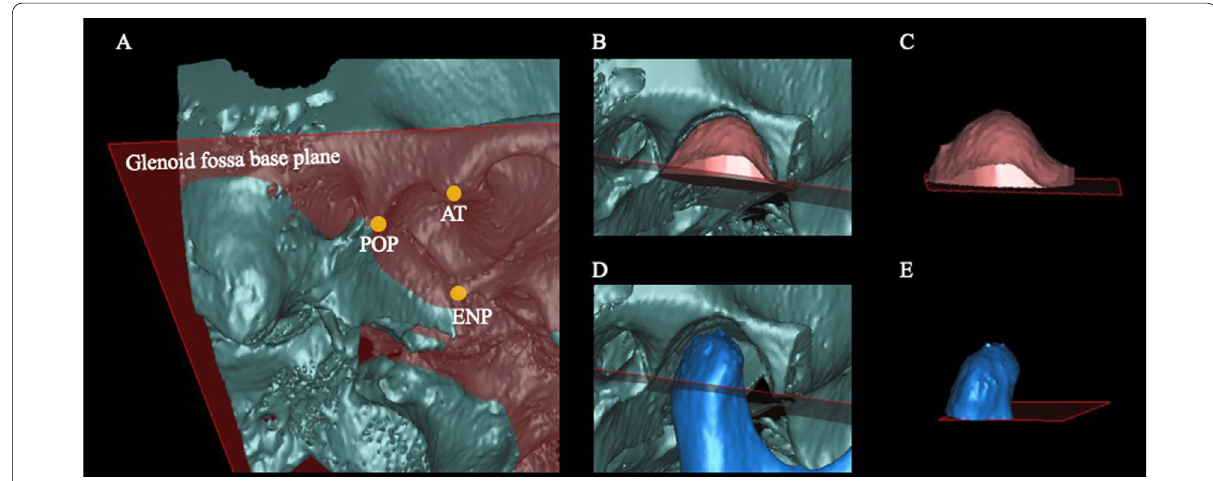
Fig. 2 Evaluation of the glenoid fossa and condyle volume. A : The glenoid fossa base was defined as the plane passing through the most inferior point of the articular tubercle (AT), the most inferior point of the entoglenoid process (ENP), and the most inferior point of the postglenoid process (POP). B and C : The glenoid fossa volume and glenoid fossa surface area were measured for the structure above the glenoid fossa base. D and E : The condyle volume was defined as the volume of the condyle above the glenoid fossa base